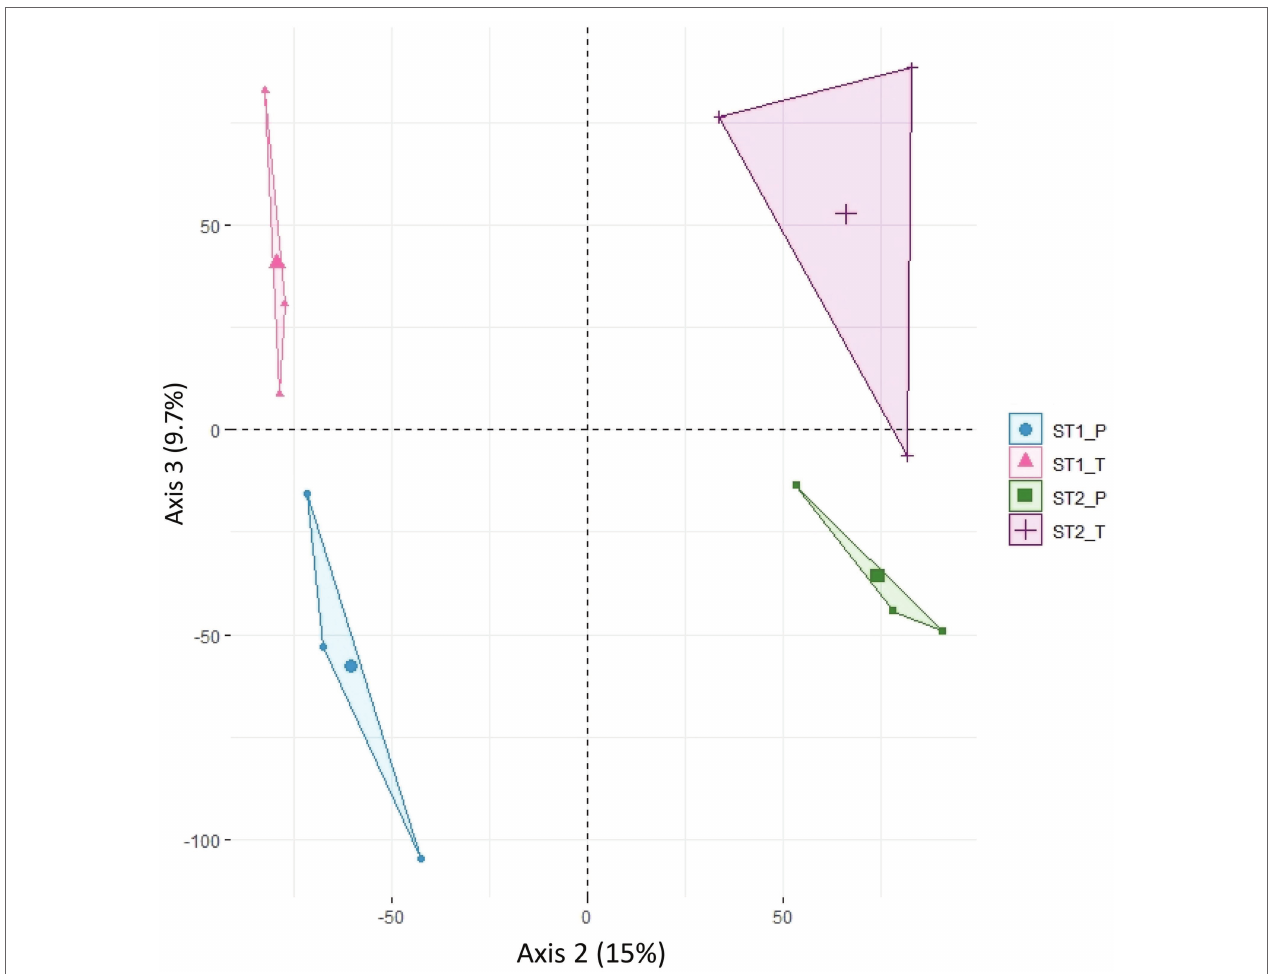
FIGURE 2 | Principal component analysis (PCA) of normalized counts for 34,614 informative transcripts. PCA was done on the four-stage x morph combinations and the three biological replicates. Axis 2 (15% of the variability) separates individuals according to developmental stage (stage 1 vs. stage 2) and axis 3 (9.7% of the variability) separates them according to morph (P morph vs. T morph). ST1_P, ST1_T: individuals at stage 1 of P and T morph, respectively; ST2_P, ST2_T: individuals at stage 2 of P and T morph,